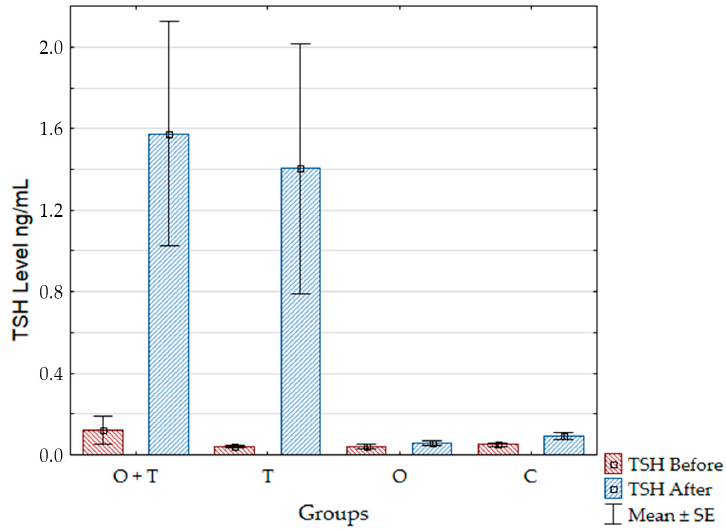
Figure 2. Thyroid Stimulating Hormone (TSH) values for the groups before and after the surgeries. SE: standard error; O + T: ovariectomized and thyroidectomized; O: ovariectomized; T: thyroidectomized; C: control. Table 1. Mean values ± standard error of the Thyroid Stimulating Hormone (TSH) levels before and after the surgeries of the studied groups and Mann-Whitney statistical test p values. Groups